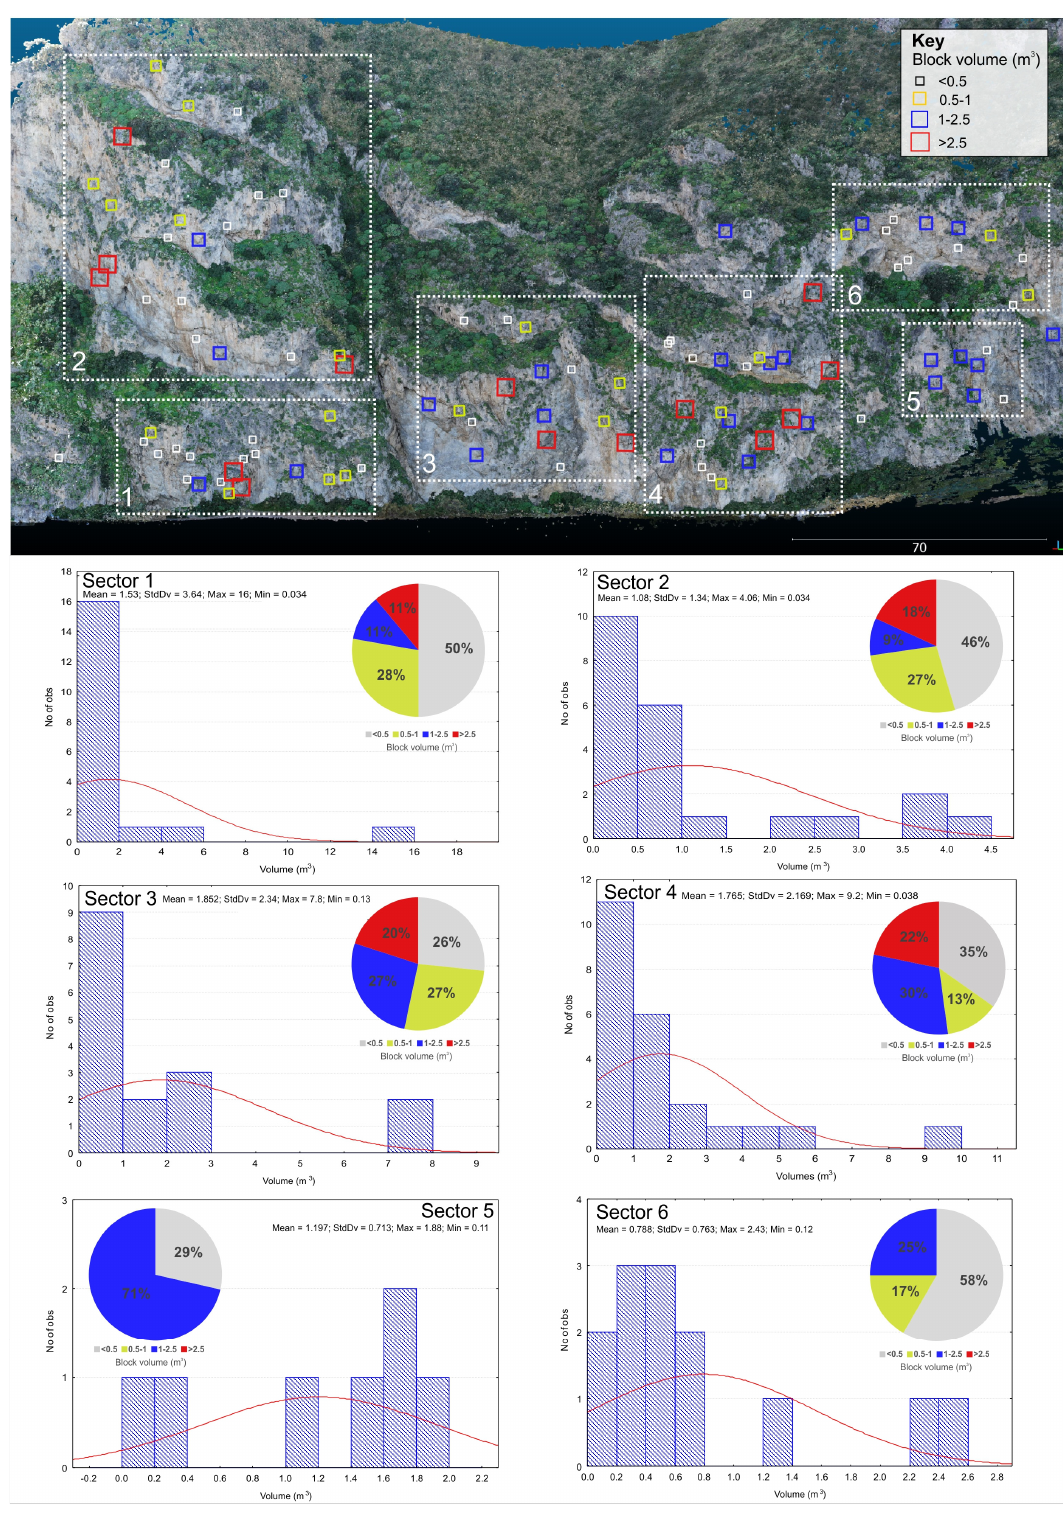
Figure 8. Location of the RGB–IRT-identified protruding volumes and related categorizations according to their volume. Histograms show the statistical distribution of estimated volumes at each sector.